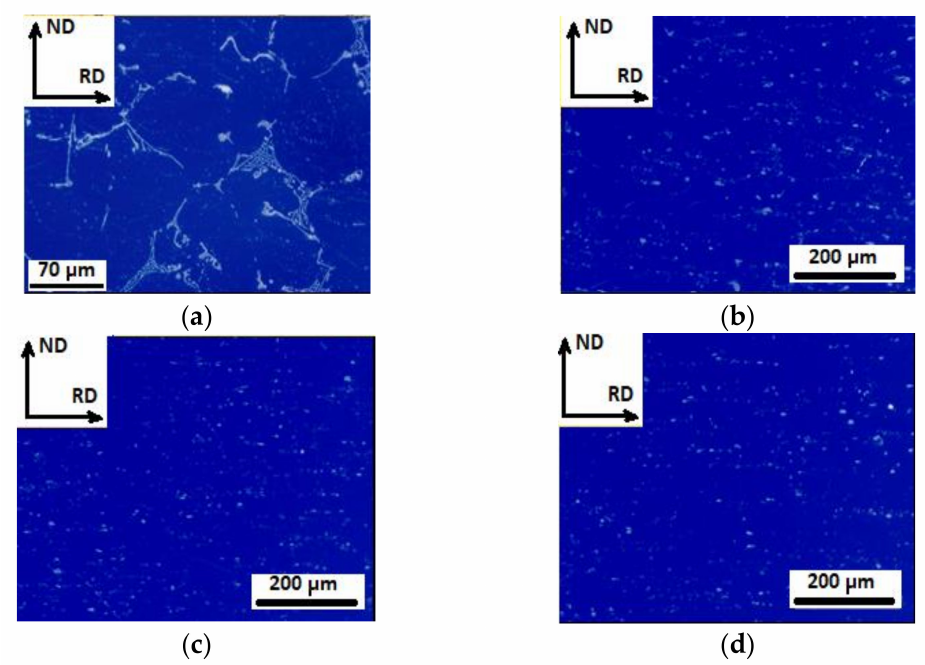
Figure 7. Micrographs of samples etched to reveal the phases of 8011 alloy: ( a ) homogenization, ( b ) 29.82% deformation, ( c ) 63.16% deformation, ( d ) 80.70%